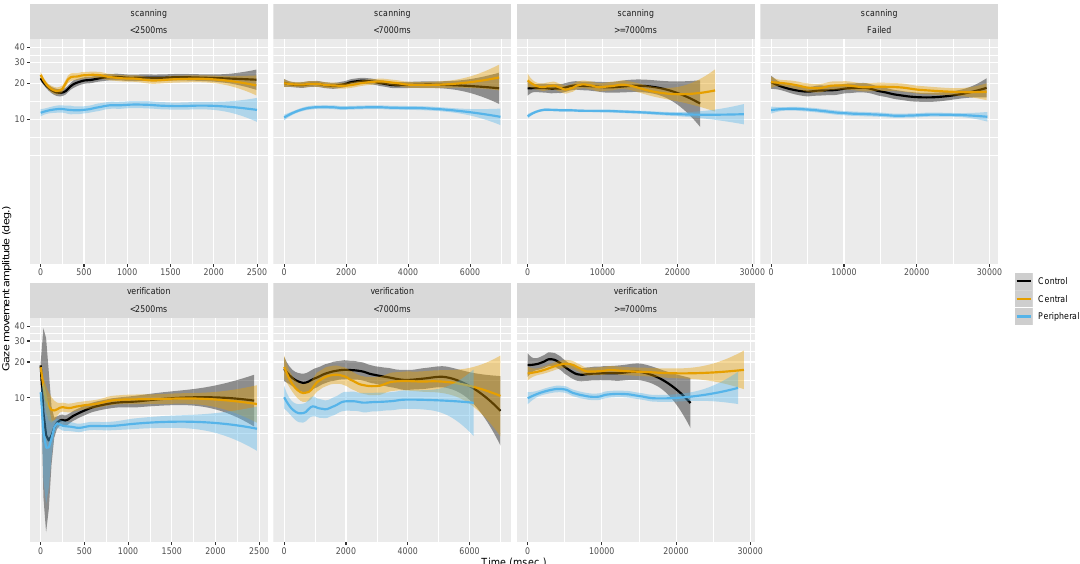
Figure A9. Time-course of average gaze movements amplitude during saccades as a function of search phase (trial duration subgroups do not overlap). Ribbons show 95%CI. Control condition appears in black, central in orange and peripheral in blue.